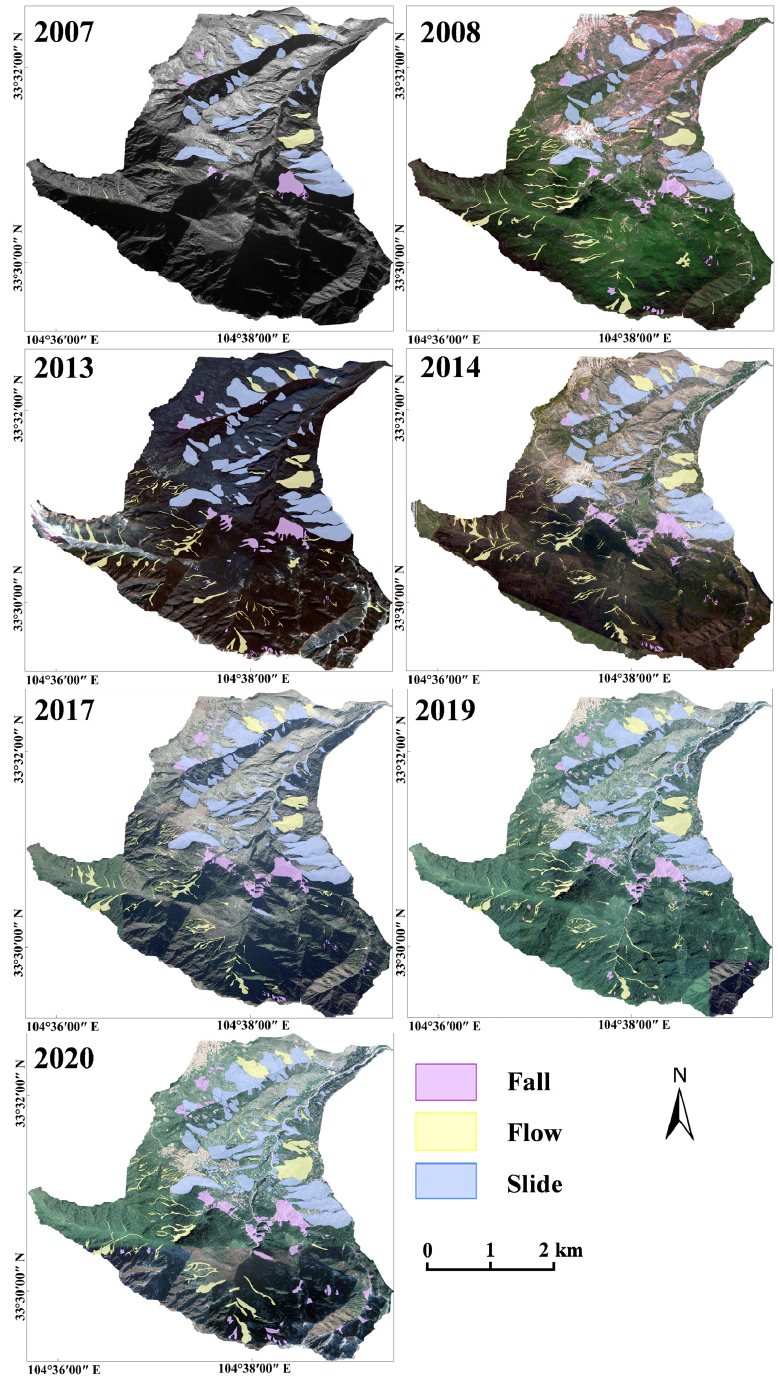
Figure 8. Spatiotemporal inventory of landslides.